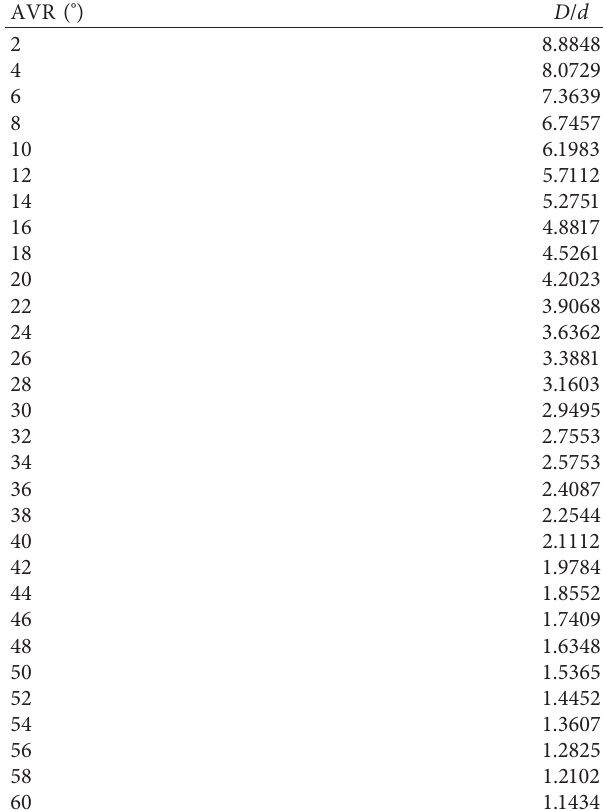
Table 4: Representative D / d values of each